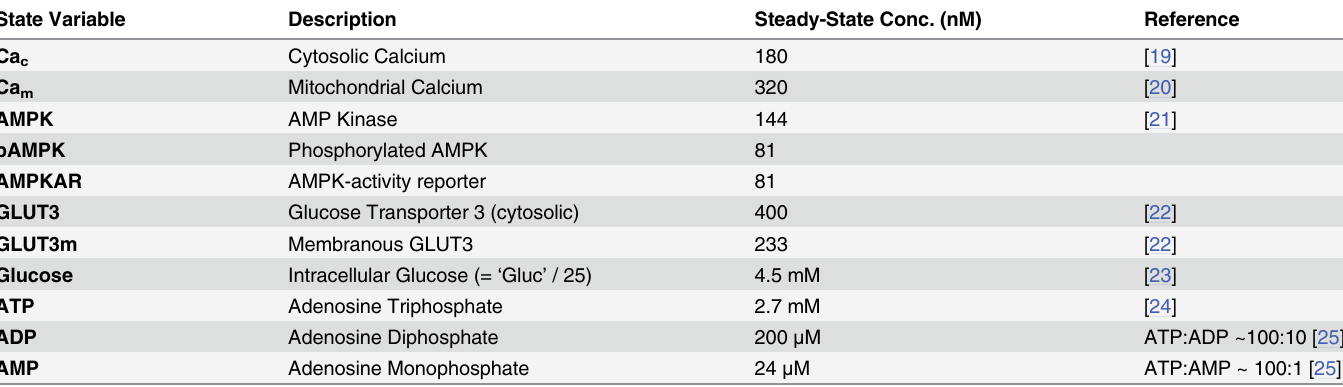
Table 1. Steady-state concentrations of modelled state variables.